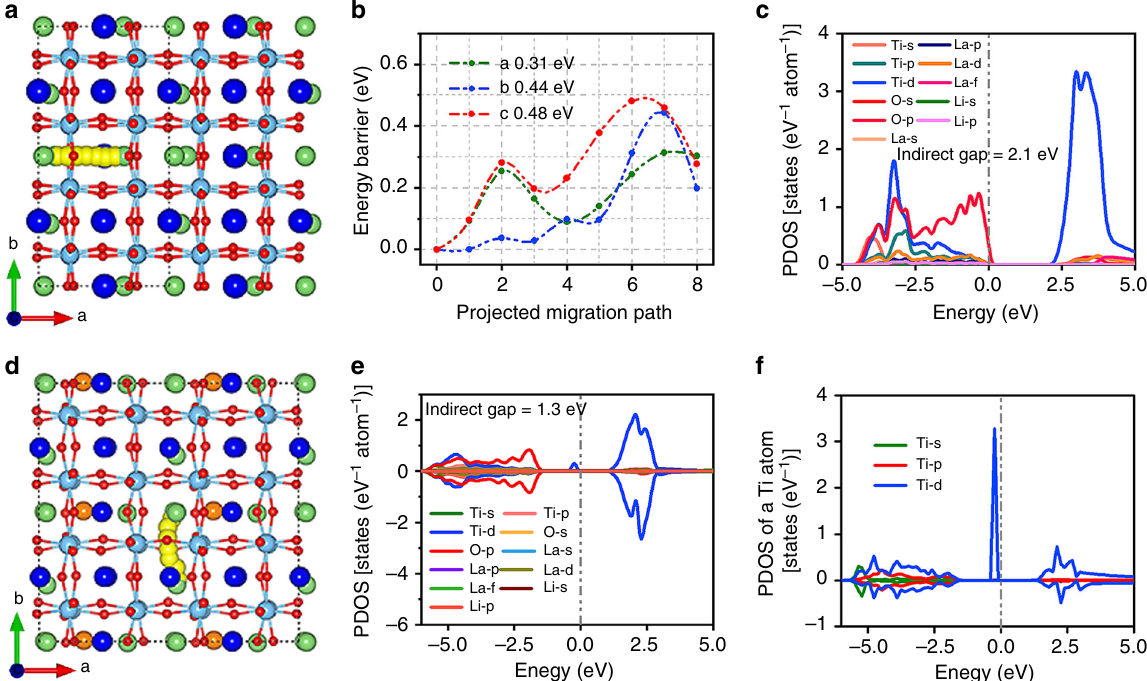
Fig. 4 Geometric/electronic structures of LLTO and lithiated LLTO. a Crystal structure and the Li + diffusion path with the lowest barrier; b Diffusion energy barrier at three-dimensional directions; c Projected density of states (DOS) of pristine LLTO; d Crystal structure with the Li + diffusion path of lithiated LLTO; e PDOS of lithated LLTO; f PDOS of magnetized Ti atom adjacent to the inserted Li atom in lithium LLTO. The green, blue, cyan, and red spheres in crystal structure represent lithium, lanthanum, titanium, and oxygen atoms, respectively.